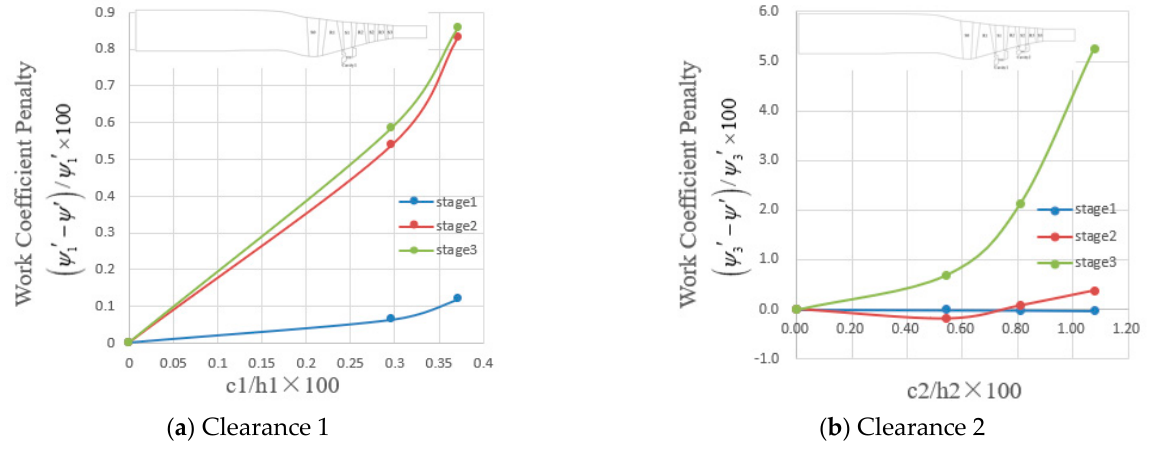
Figure 12. Stage work coefficient penalty for varying seal-tooth clearance.